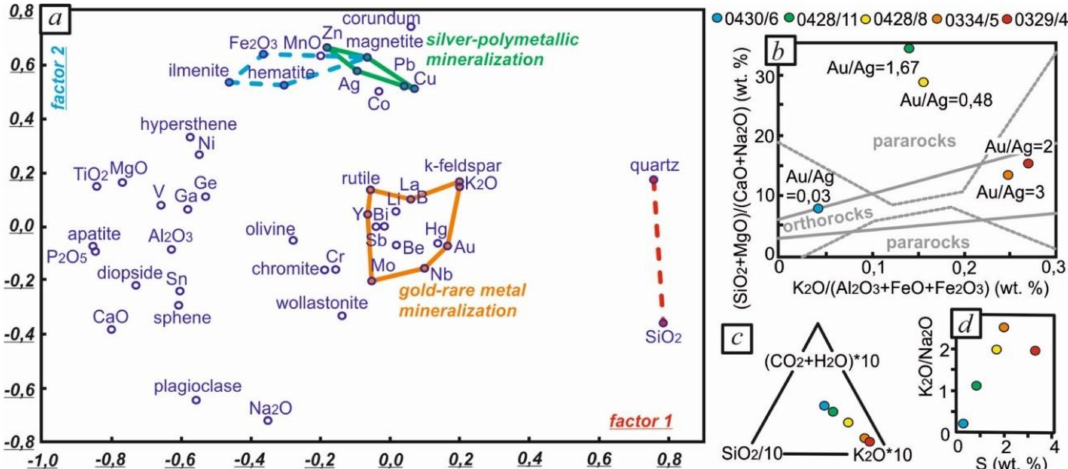
Figure 9. Geochemical signatures of gold-bearing rocks from the Billyakh zone. ( a ) Results from a factor analysis of geochemical data [31]; ( b – d ) trends in the Au and Ag distribution in the rocks [32]. Gold samples: 0430 / 6, biotite plagiogneiss, tonalite (Au 0.2 ppm, Ag 6.0 ppm); 0428 / 11, biotite plagiogneiss, arkose (Au 1.0 ppm, Ag 0.6 ppm); 0428 / 8, biotite plagiogneiss, arkose (Au 1.0 ppm, Ag 2.1 ppm); 0334 / 5, biotite gneiss, granosyenite (Au 0.9 ppm, Ag 0.3 ppm); 0329 / 4, hypersthene gneiss, granosyenite (Au 1 ppm, Ag 0.5